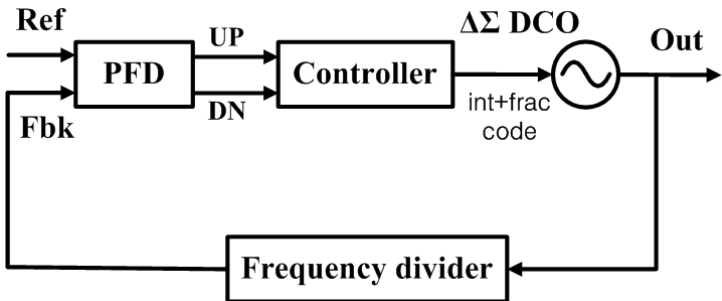
Figure 1. The controller-based all-digital phase-locked loop (ADPLL) architecture.